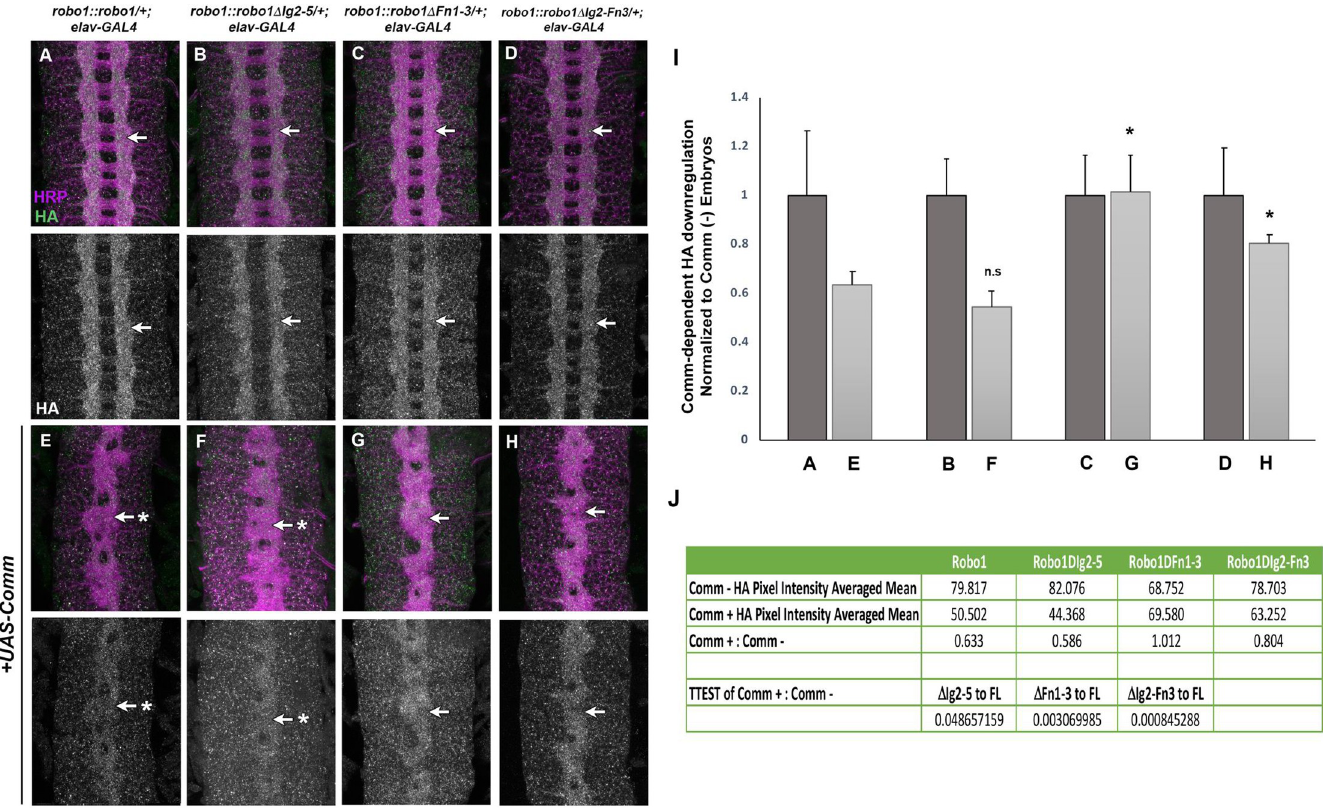
Fig 5. Robo1’s Fn3 domain is required for Comm-dependent downregulation. Stage 16 embryos stained with anti-HA (green) and anti-HRP (magenta). Lower images show HA channel alone of the same embryos. (A-D) Embryos with one copy of the transgene as well as elav-GAL4 display normal Robo1 protein expression among the HA-tagged variants (arrows). (E-H) Homozygous transgenic embryos carrying elav-GAL4 and UAS-Comm show strongly downregulated HA expression among the slit-like collapsed axon scaffold (arrows with asterisks), with the exceptions of Robo1 Δ Fn1-3 and Robo1 Δ Ig2-Fn3 (G and H) which are not downregulated on axons when Comm is misexpressed (arrow). Pairs of sibling embryos shown (A and E; B and F; C and G; D and H) were stained in the same tube and imaged under the same confocal settings to ensure accurate comparison of HA levels between embryos. Bar graph (I) and table (J) show quantification of pixel intensity of full-length and combinatorial Robo1 variants with either elav-GAL4 alone (A-D) or elav-GAL4 and Comm (E-H). Error bars indicate s.d. For each of these variants, the degree of HA downregulation was compared to that of full-length Robo1 by a two-tailed Student’s t-test, with a Bonferroni correction for multiple comparisons ( � p < 0.01). n = 5 for each UAS-Comm and elav-GAL4